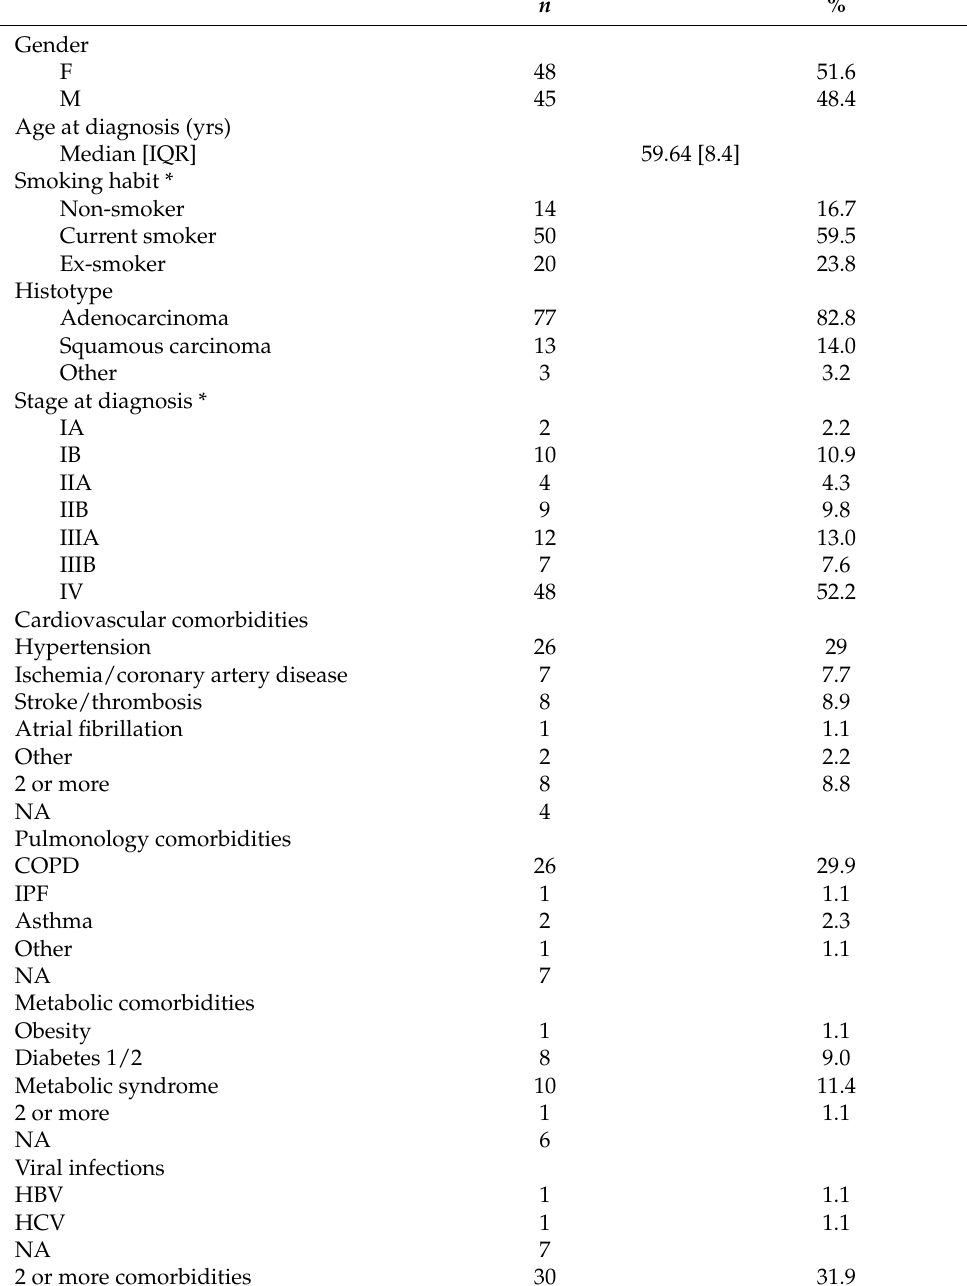
Table 1. Clinico-pathological patient’s characteristics ( n =